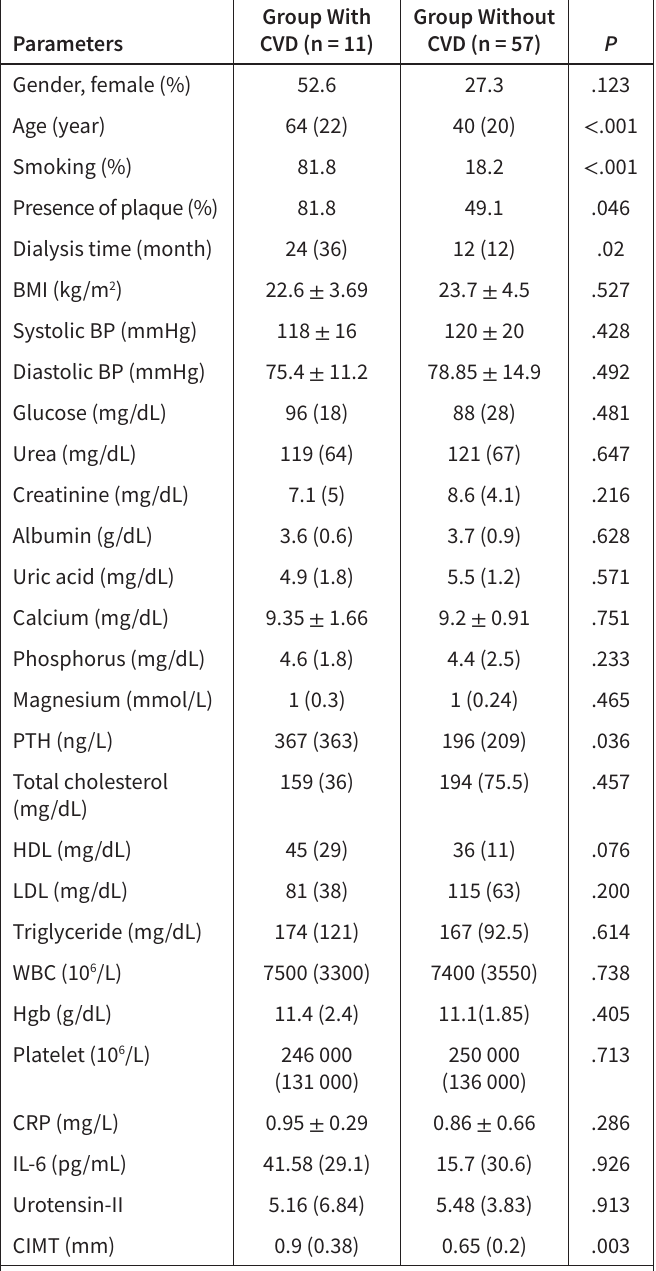
Table 5. Comparison of Basic Characteristics and Laboratory Parameters Between the Subgroups of Dialysis